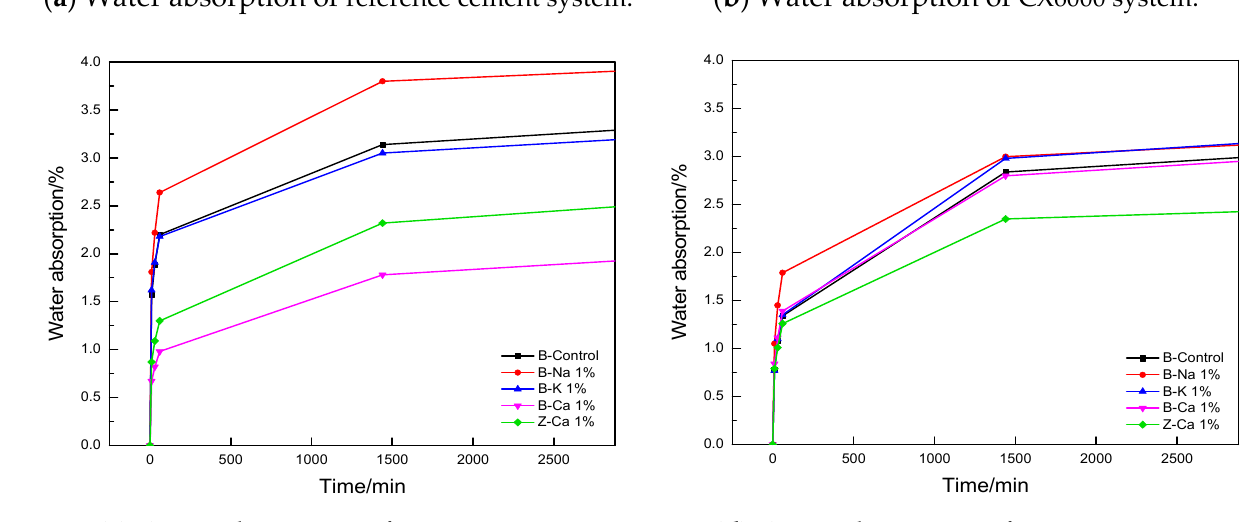
( d ) Water absorption of CX8000 system. Figure 3. Water absorption of ultrafine cement. Figure 3. Water absorption of ultrafine cement.